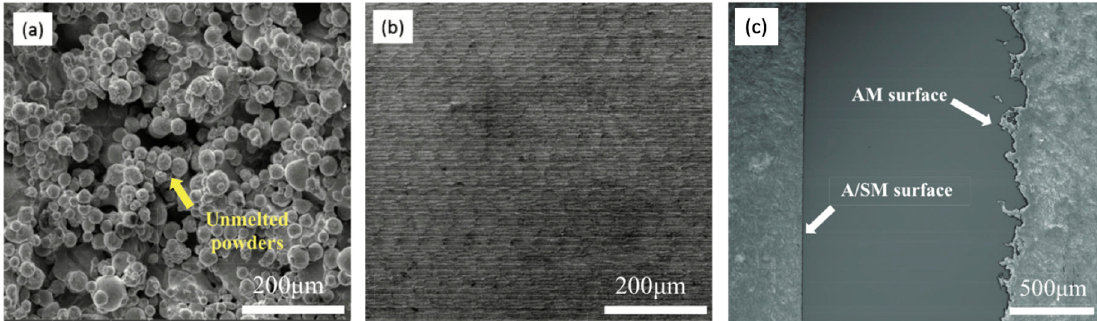
Figure 17. Surface morphology of as-printed parts ( a ), from hybrid SLM and machining process ( b ) and ( c ) [25].